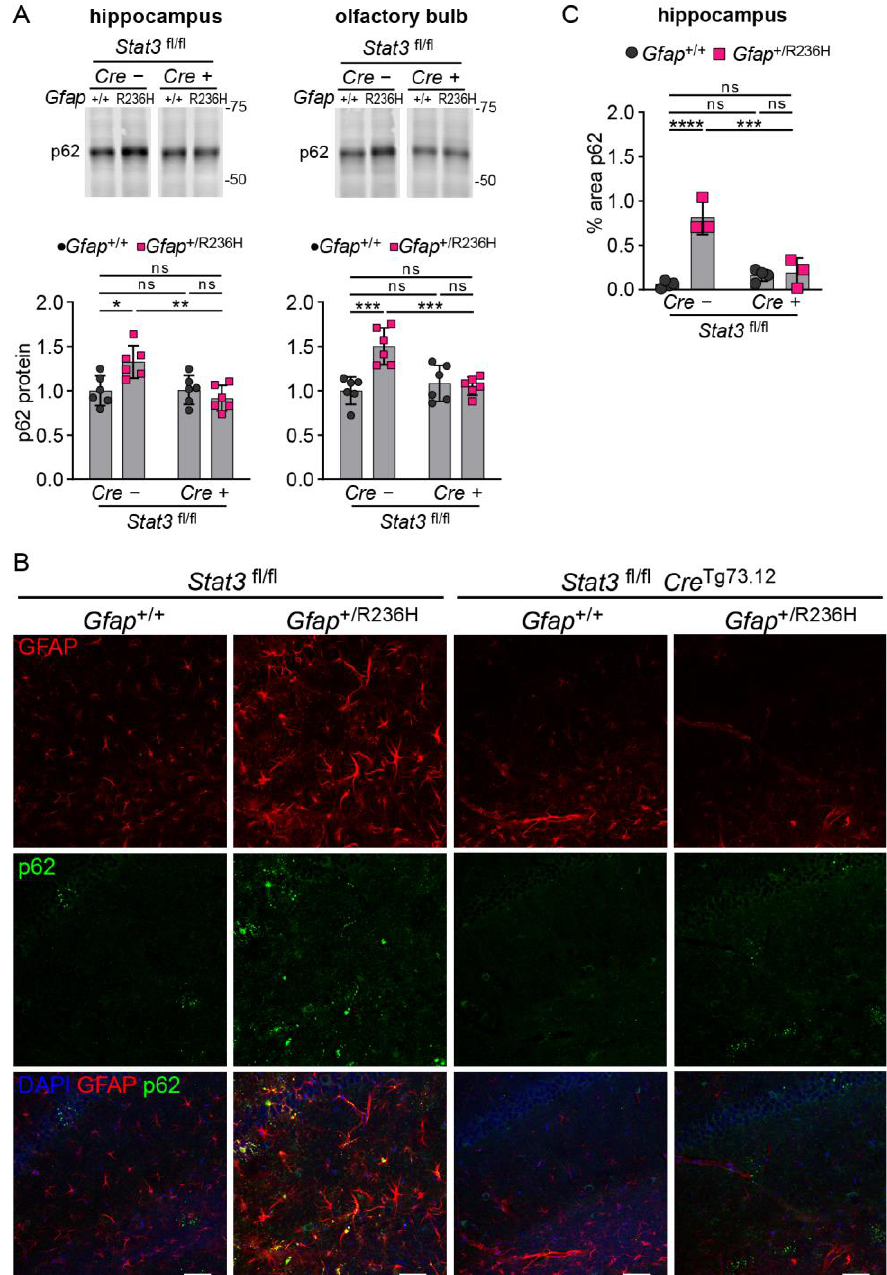
Figure 5. p62/SQSTM1 expression and protein aggregation in AxD model mice with conditional knockout of Stat3 in Gfap expressing cells. ( A ) Quantification of p62/SQSTM1 protein in olfactory bulb and hippocampus from Gfap +/R236H mice and Gfap +/+ littermate controls (3 months of age) collected from the same Stat3 fl/lf ; Cre Tg73.12 genetic cross as shown in Figure 4A. ( B , C ) Immunofluorescence labeling of p62 and GFAP in hippocampus ( B ), and quantification of percent area for p62 ( C ) in mice from the same cross at 6 months of age. Values in ( A ) are normalized to total protein and represent fold change relative to the average for Gfap +/+ ; Stat3 fl/fl ; Cre (-) mice. C57BL/6J males and females, two-way ANOVA with Sidak’s post-tests, * p < 0.05, ** p < 0.01, *** p < 0.001, **** p < 0.0001, ns = not significant. Scale bars = 50 µm.